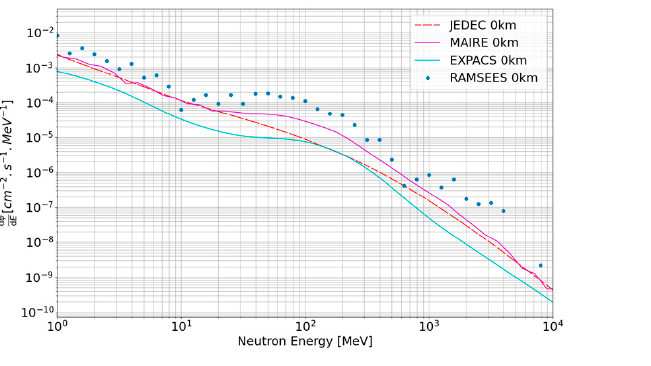
Figure 14. Comparison between RAMSEES results at 3 km and experimental data at 2.9 and 3.5 km from Hubert et al. [40].